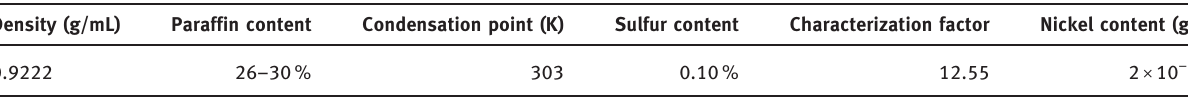
Table 1: The main properties of Daqing heavy oil (conditions: density, paraffin content, condensation point, sulfur content, characterization factor, and nickel